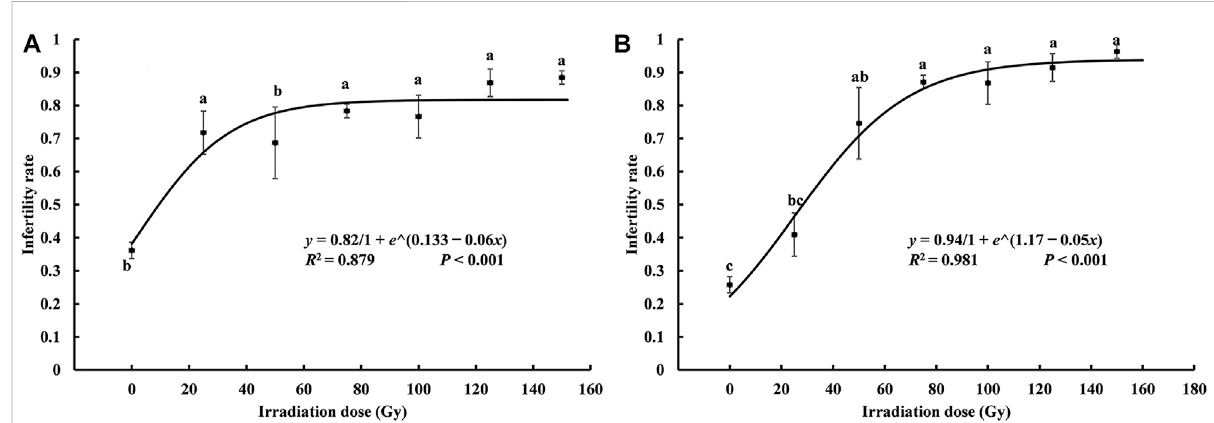
FIGURE 2 Curve oftherelationshipbetween thesterilityrateof Spodoptera litura hybridsandX-ray irradiation dose. (A) thesterilityrateofX-ray irradiated femalepaired with unirradiated male; (B) thesterilityrate ofunirradiated female pairedwith ofX-ray irradiatedmale. Data aremeans±SE; signi fi cant differences (one-way ANOVA, Tukey ’ s HSD; p < 0.05) among doses for a variable are indicated by different lowercase